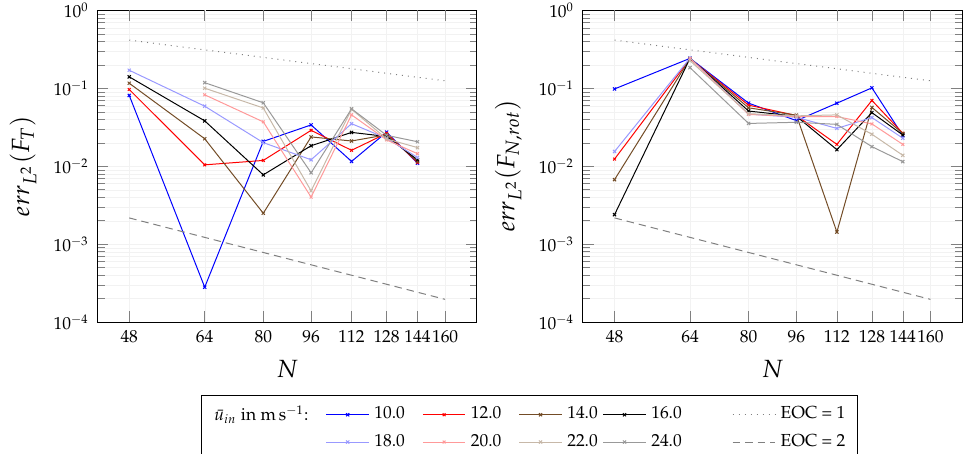
Figure 17. Error err L 2 of tangential and standard normal force for different inflow velocities ¯ u in . Reference solution χ ref at N = 160. Quadratic and linear EOC as guidelines.